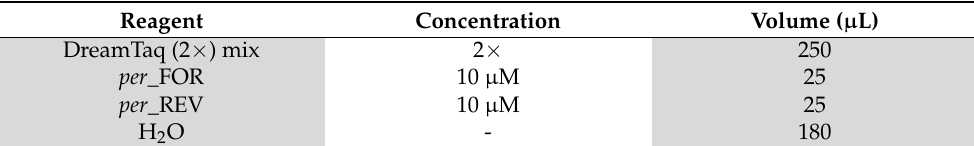
Table 3. Setup of DreamTaq master